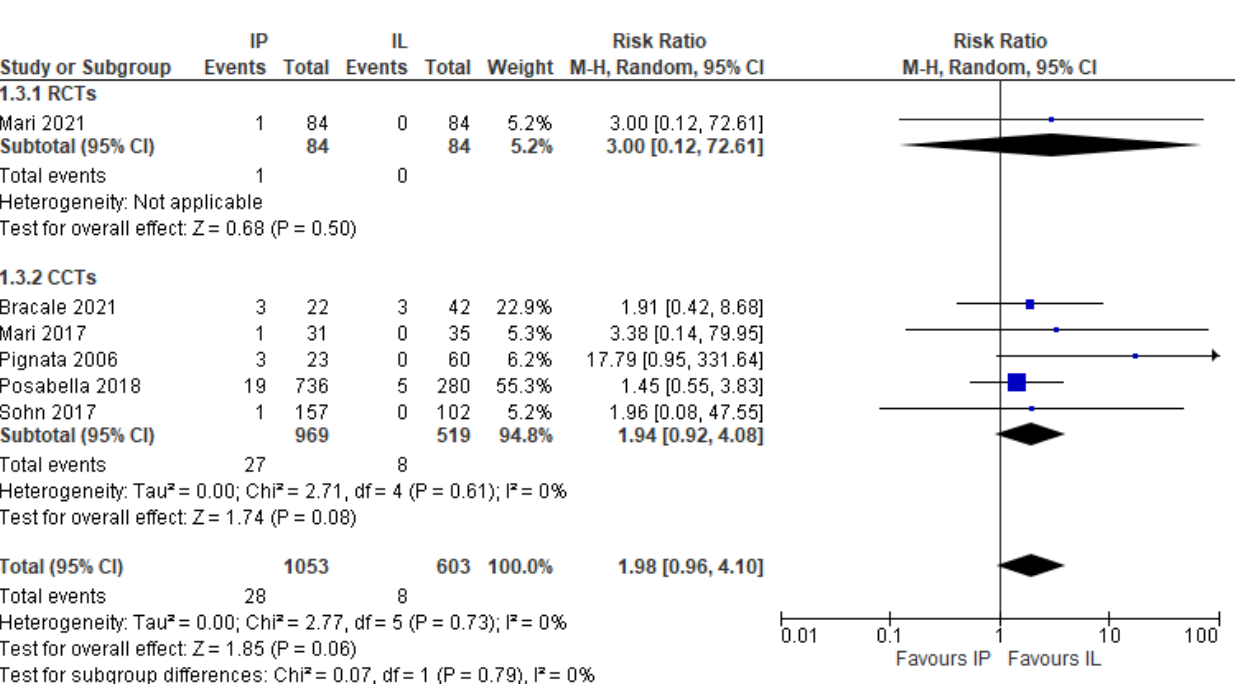
Figure 6. ( a ) Anastomotic leak, risk ratio, IMA preservation vs. IMA high ligation. ( b ) Anastomotic leak, risk ratio, IMA preservation vs. IMA low ligation.